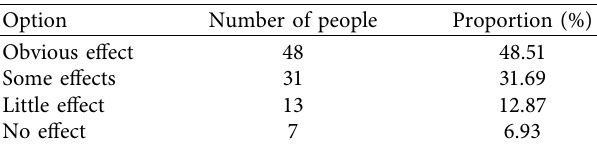
Table 2: Whether it is effective to study mental health education courses after optimization.